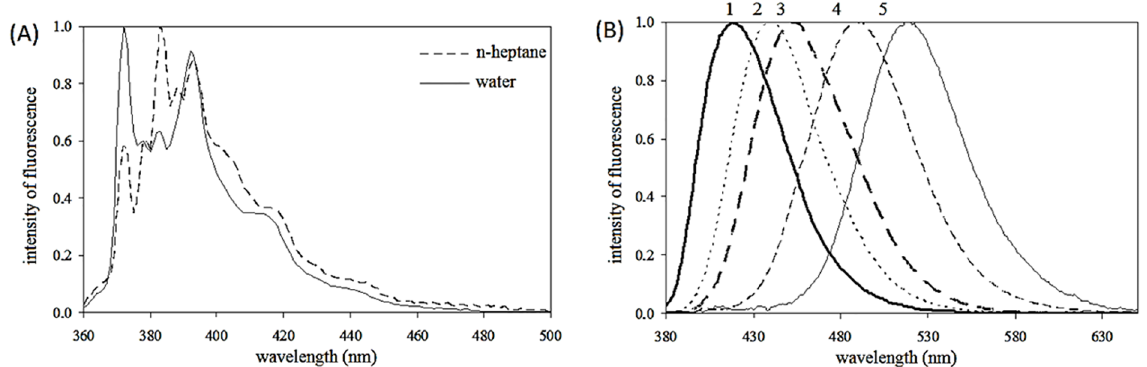
Fig 2. Normalized emission spectra of (A) pyrene in n-heptane and water solution (B) prodan in toluene 1 , chlorophorm 2 , dimethylformamide 3 , ethanol 4 and water 5 solution.